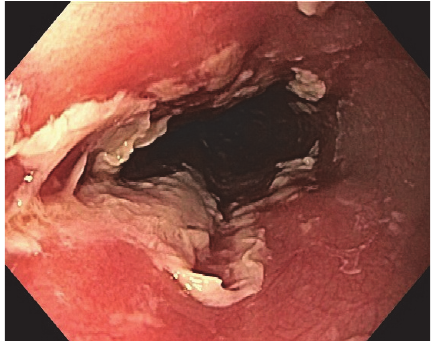
Figure 3: Endoscopic image of extensive ulcerative esophagitis in the mid-esophagus.